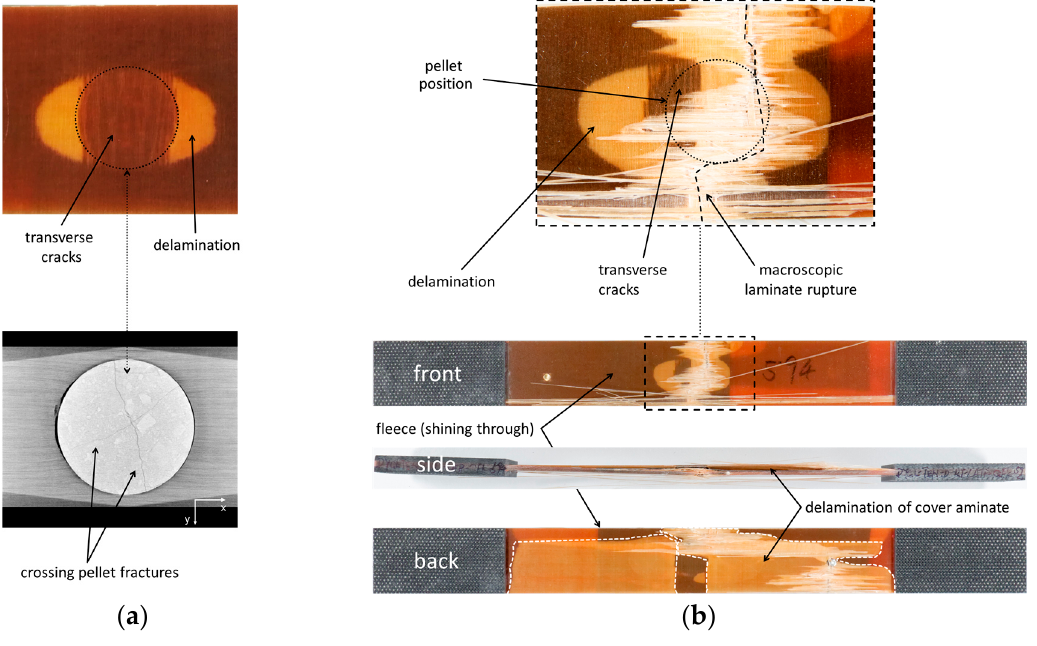
Figure 10. Exemplary LATP–GFRP tension specimen after mechanical testing: ( a ) surface photo of the specimen and CT image of the embedded pellet at about 64% of the ultimate load; ( b ) front, side, and back views of the same specimen after final failure. and back views of the same specimen after final